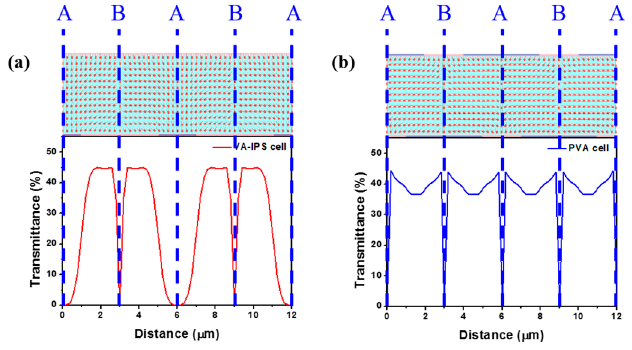
Figure 6. LC director orientations and transmittance distributions in ( a ) VA-IPS and ( b ) PVA cells. Crystals 2017, 7, 201